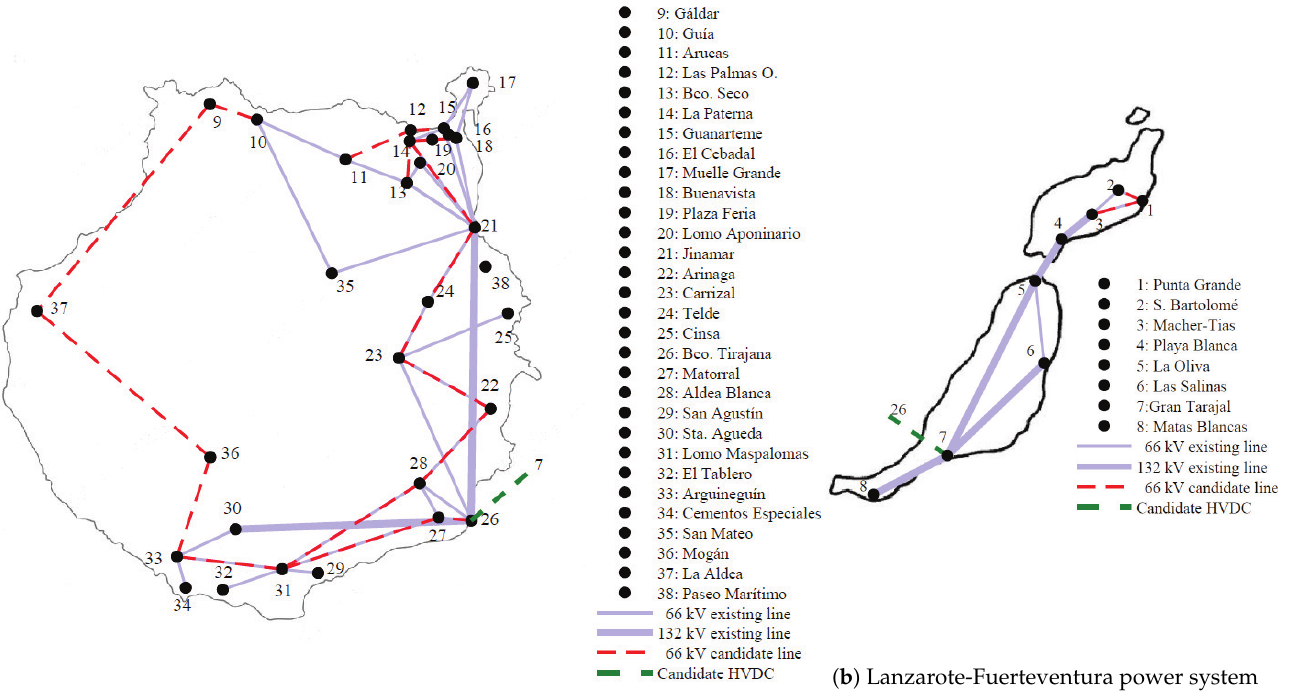
Figure 2. Single-line diagram of Las Palmas power